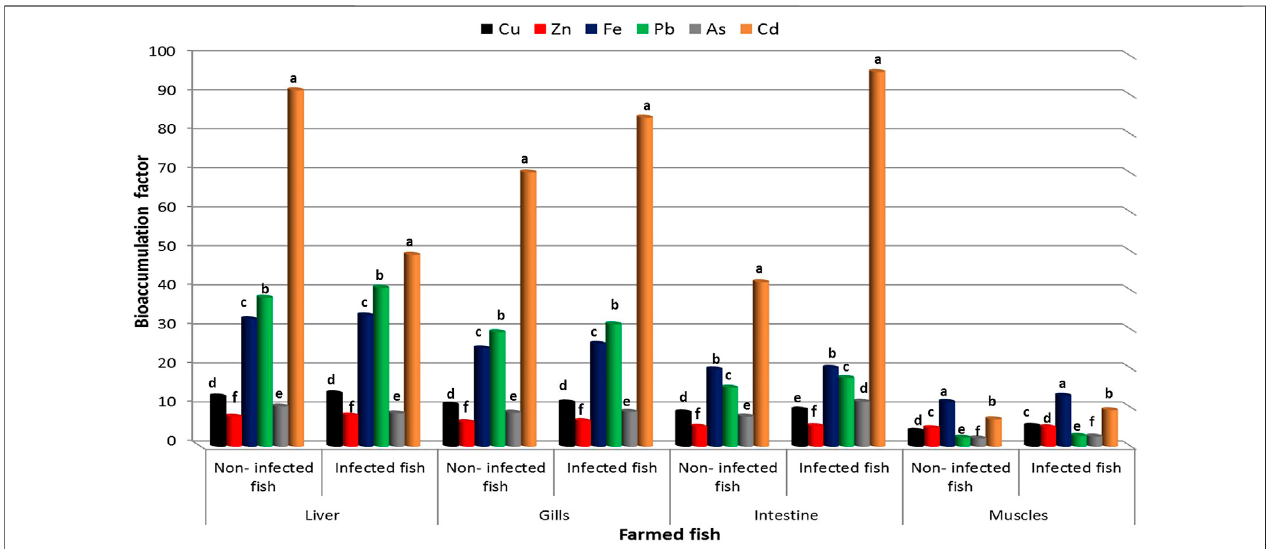
FIGURE 5 | Bioaccumulation factor of heavy metals in different organs of farmed Nile Tilapia, O. niloticus .